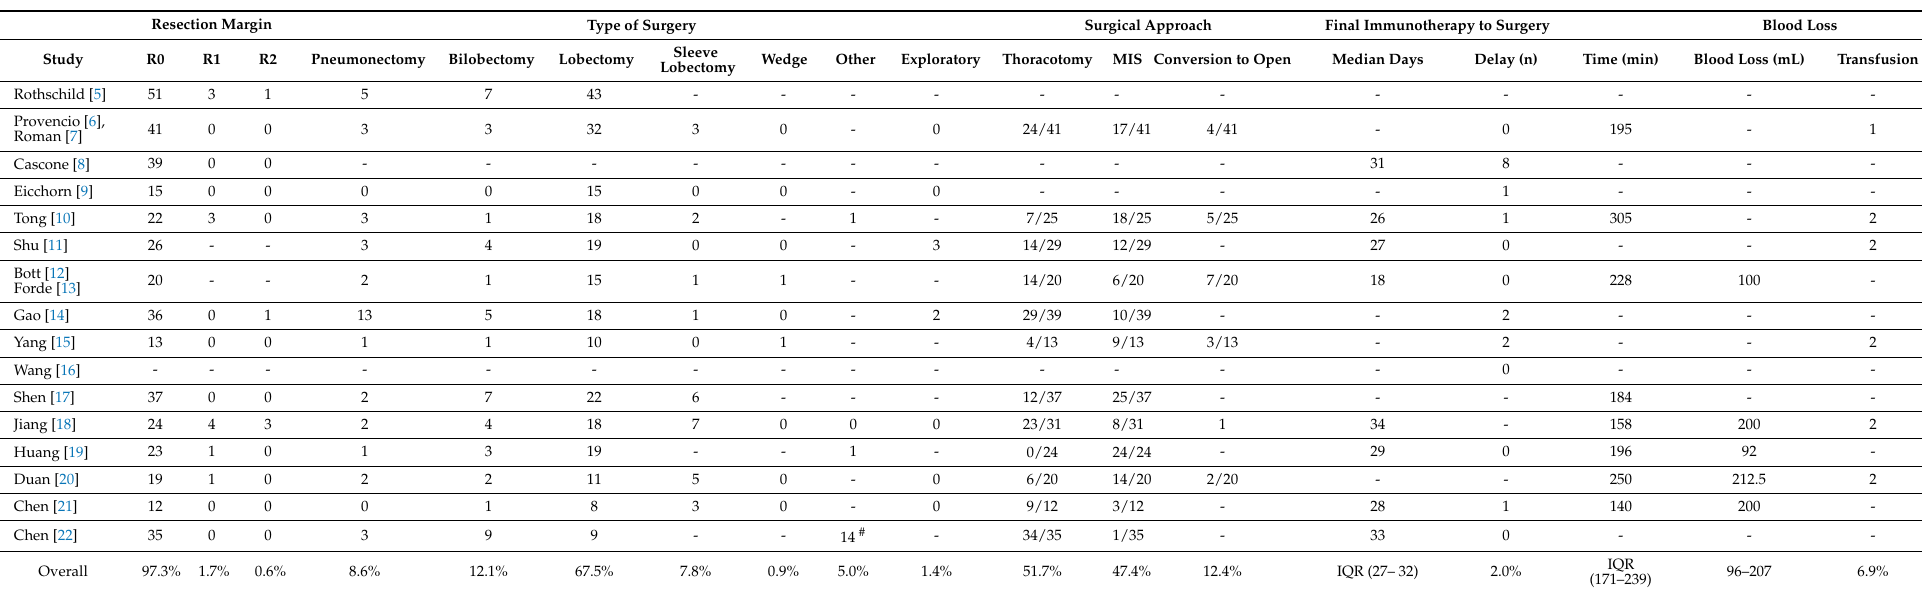
Table 3. A summary of operative details for patients who underwent neoadjuvant immunotherapy in the treatment of resectable non-small cell lung cancer. ResectionMargin TypeofSurgery